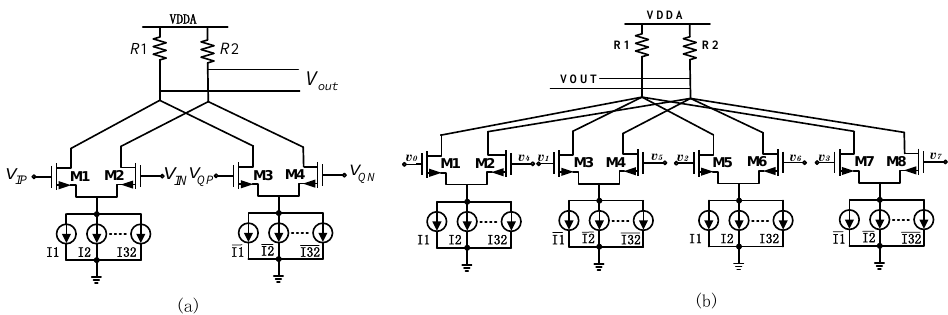
Figure 17. Shown two PI designs. ( a ) Traditional PI design, ( b ) improved PI design.